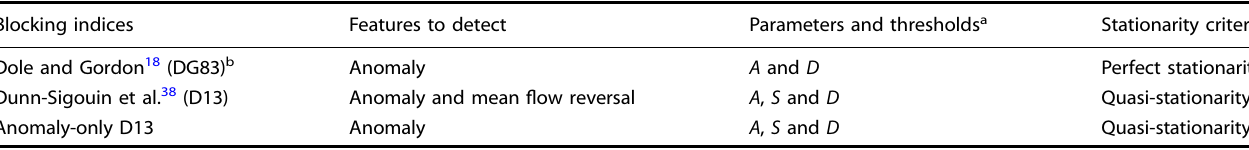
Table 1. Blocking indices